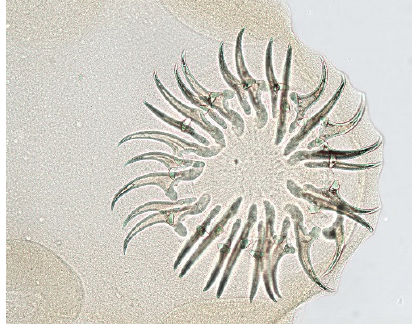
Figure 14. Taenia crassiceps scolex.